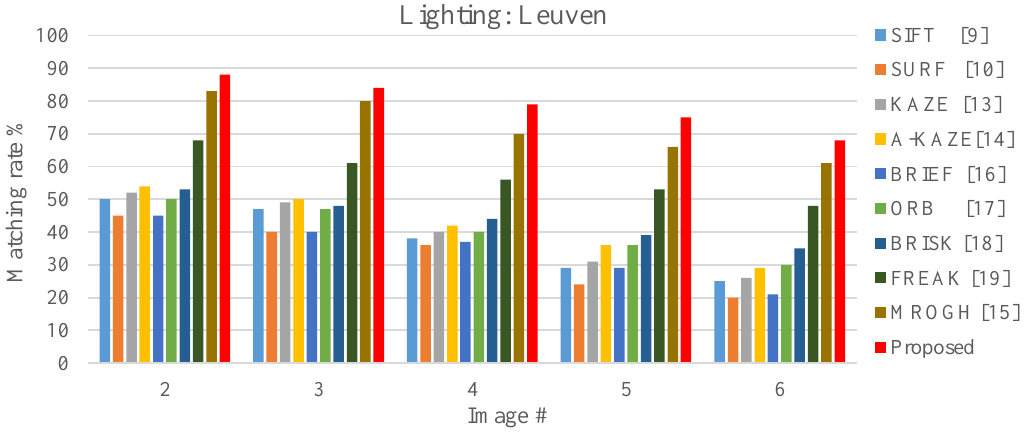
Figure 23. Local stable feature matching outcomes under various lighting levels.